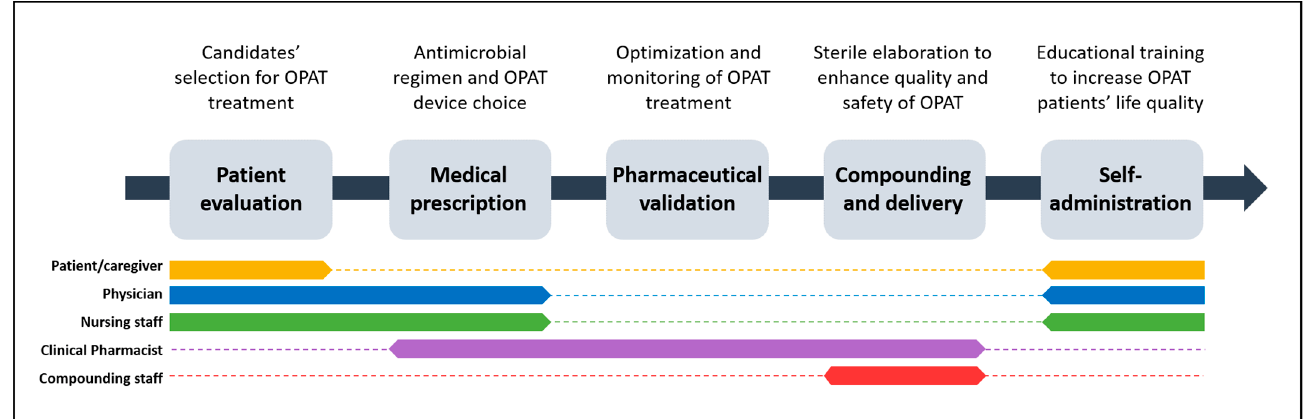
Figure 1. OPAT multidisciplinary circuit at Parc Taulí University Hospital. The central diagram indicates the five stages of the circuit. The headings above summarize the main contribution of each stage to the OPAT program. The bottom colored dotted lines individually represent patients/caregivers, all members of OPAT team, and the compounding staff. Thicker lines below a specific stage indicate a major contribution to the corresponding stage.